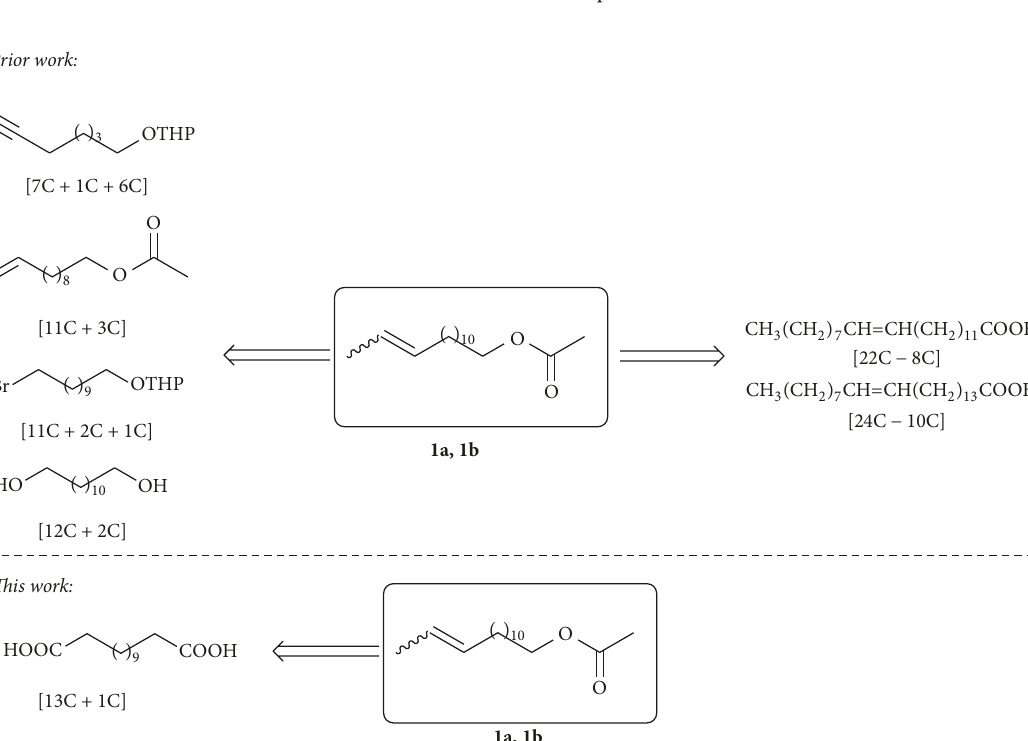
Figure 1: Chemical structure of the sex pheromone of ACB.